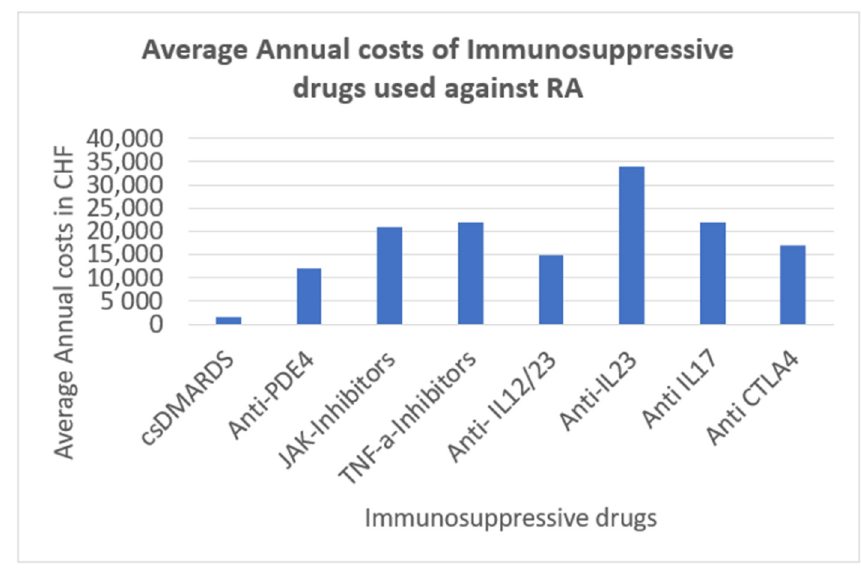
Figure 1. Average annual costs of immunosuppressive drugs against RA